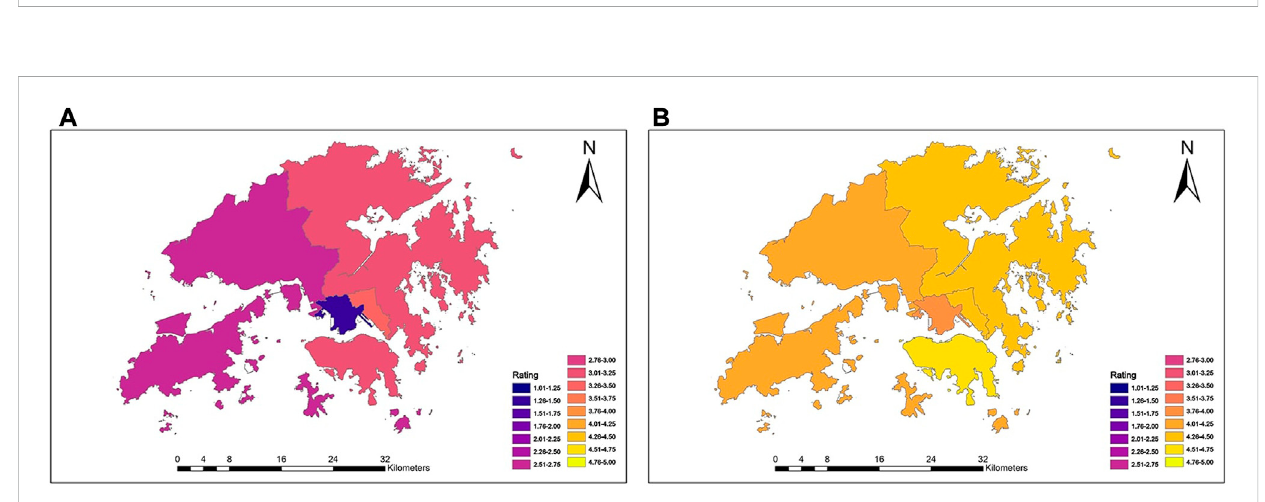
FIGURE 8 The public rating of about (A) the adequacy of the recycling bins and (B) their initiatives to support waste